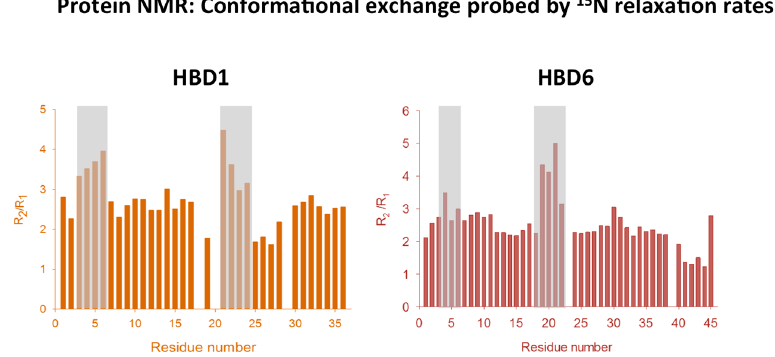
Figure 2. Backbone dynamics of β‐ defensins. Analysis of 15 N spin relaxation parameters revealed regions undergoing microsecond to millisecond motions. Note grey areas for a direct comparison between regions of conformational exchange in the two β‐ defensins. Figure adapted from [32] and [41].